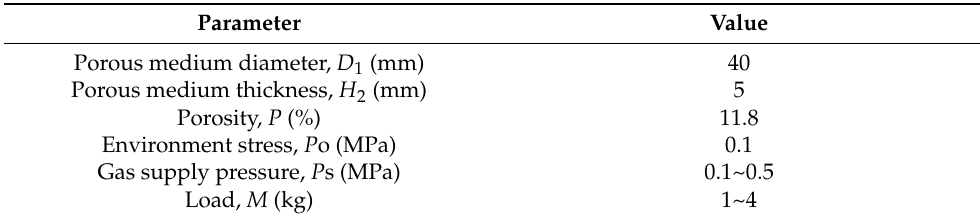
Table 2. The static measurement of experimental parameters of the air